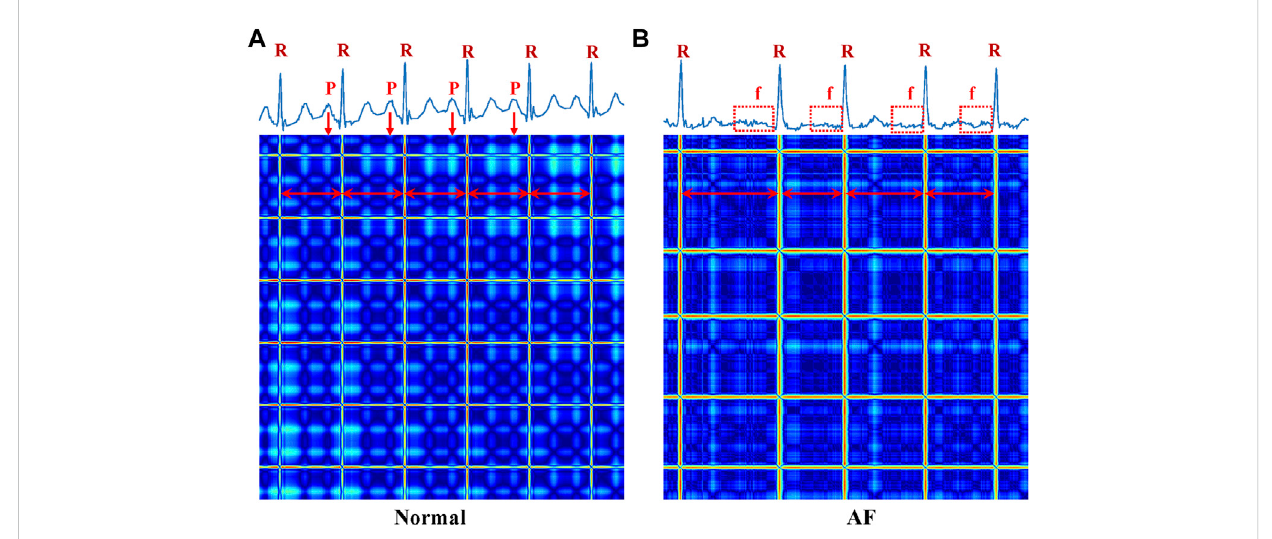
FIGURE 6 ECGtime-series(up)andcorrespondingRP(below)imagesofNormalandAF. (A) Normal (B) AF.R,theRpeakoftheECG;P,thePpeakoftheECG;f, the f wave of the